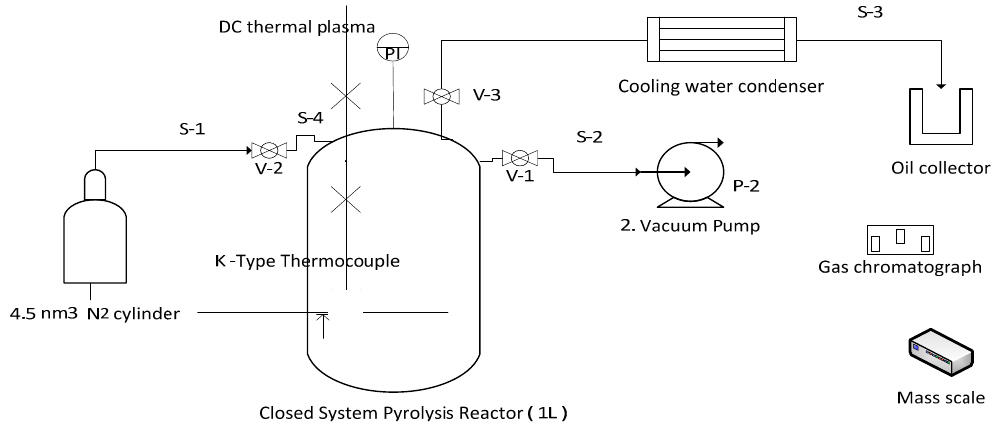
Figure 5. Experimental setup.